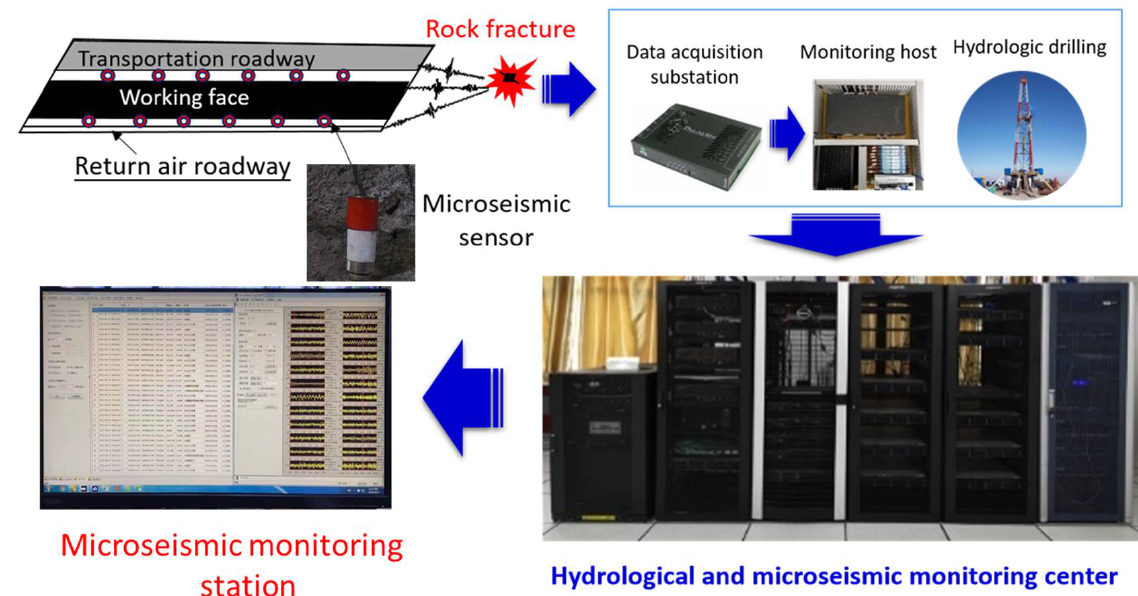
Figure 6. Flow chart of microseismic monitoring.